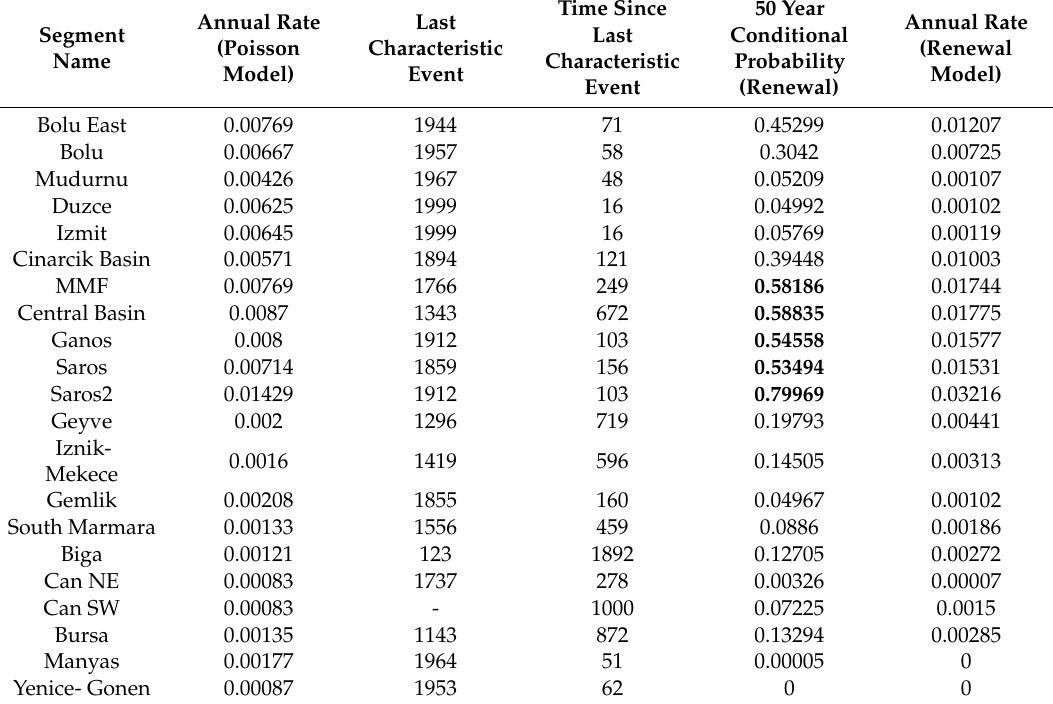
Table 4. Time-dependent 50-year probabilities and corresponding annual rates of occurrence of characteristic